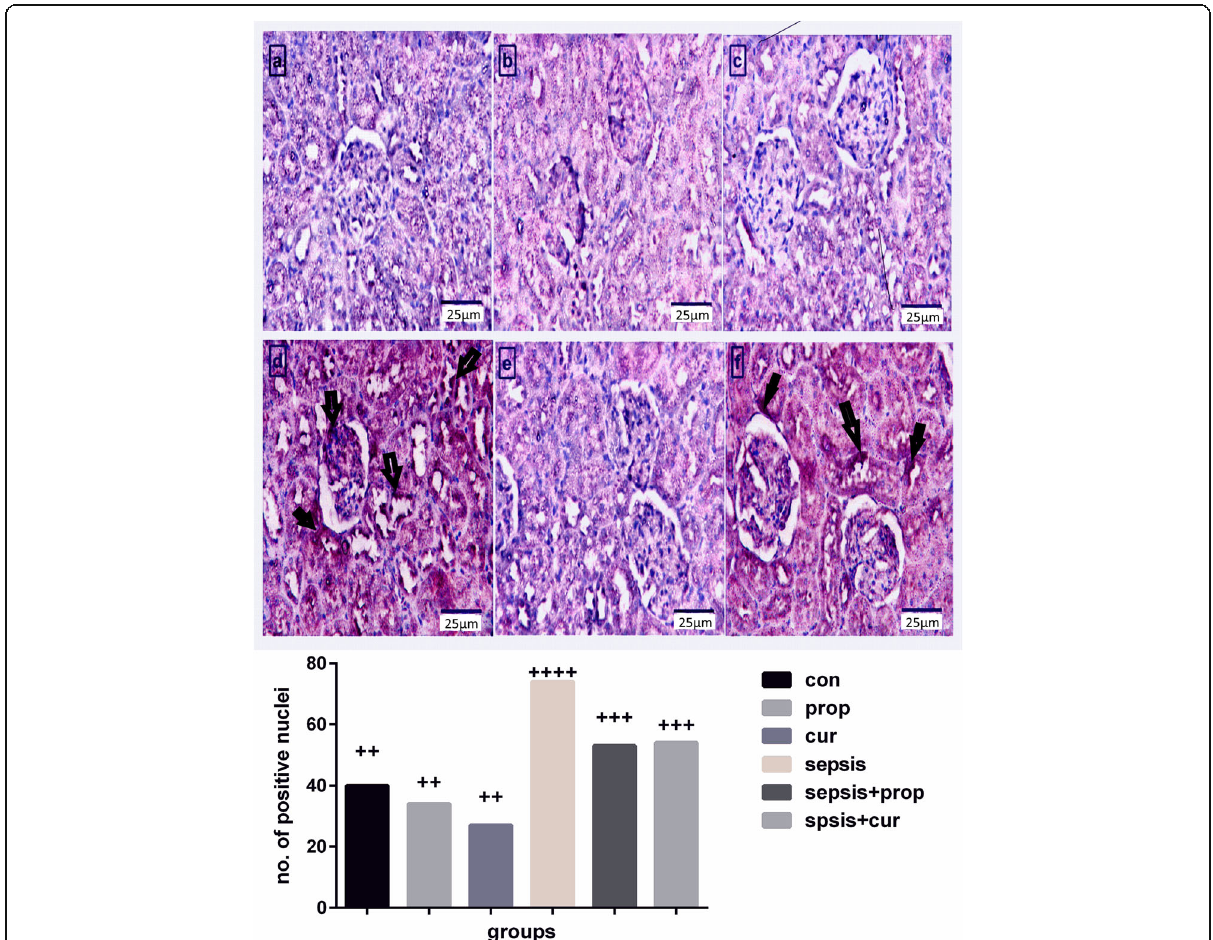
Fig. 6 Immunohistochemical expression of NF-kB in rat kidney sections with magnification × 400. A photographic of kidney section of rat were treated with vehicle showing weak expression of NF-kB ( a ), another section of kidney tissue for rat treated with curcumin showing weak expression of NF-kB ( b ), kidney section of rat treated with propolis showing weak expression of NF-kB ( c ), kidney section of rat after induction of sepsis showed strong expression of NF-kB ( d ), a section of kidney tissue from a rat subjected to sepsis after treated with curcumin showing weak expression of NF-kB ( e ), a section of kidney tissue from a rat subjected to sepsis after treated with propolis showing moderate expression of NF- kB ( f ). Arrows show immunopositive